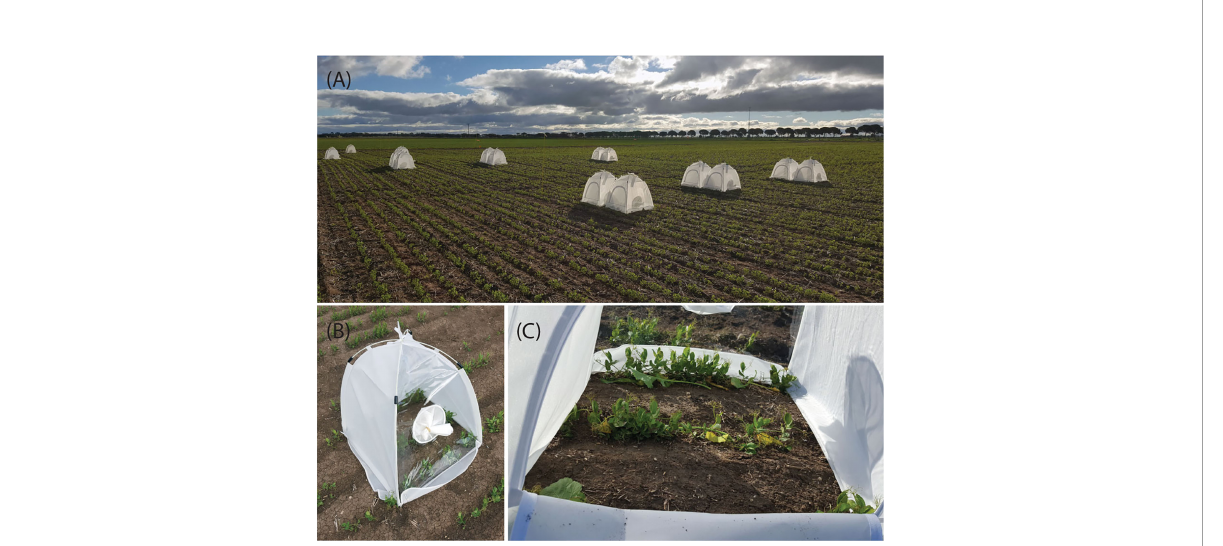
FIGURE 1 Insect cages covering experimental plots during inoculation with turnip yellows virus (TuYV) using viruliferous aphids ( Myzus persicae ) during 2020 ( A , two cages per plot); an insect cage covering fi eld pea seedlings in 2018 (B) ; fi eld pea plants covered by an insect cage with pieces of canola plant containing viruliferous aphids ( M. persicae ) placed alongside each plant (C)